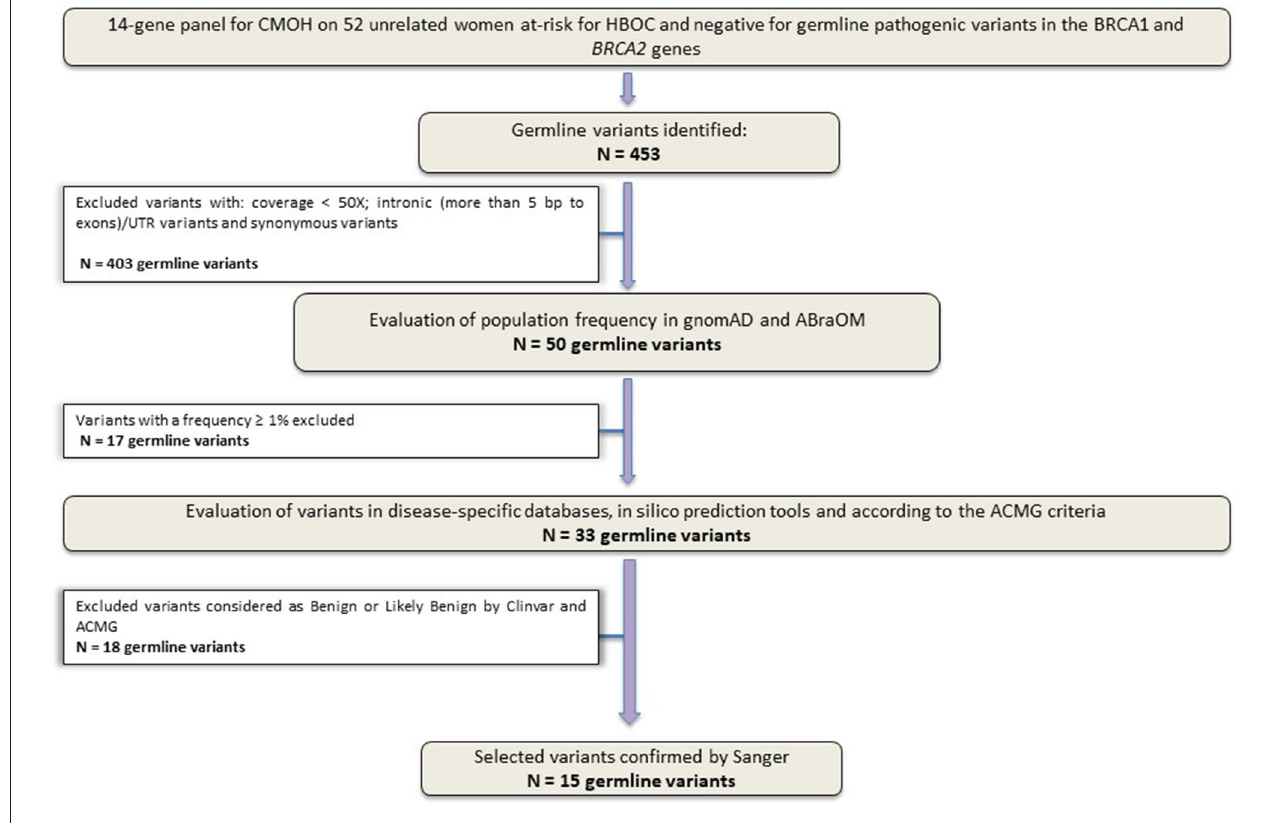
FIGURE 1 | Study design flowchart. Variants selection workflow. Panel sequencing data from 52 unrelated Brazilian women at-risk for HBOC, without germline pathogenic variants in BRCA1 and BRCA2 genes.